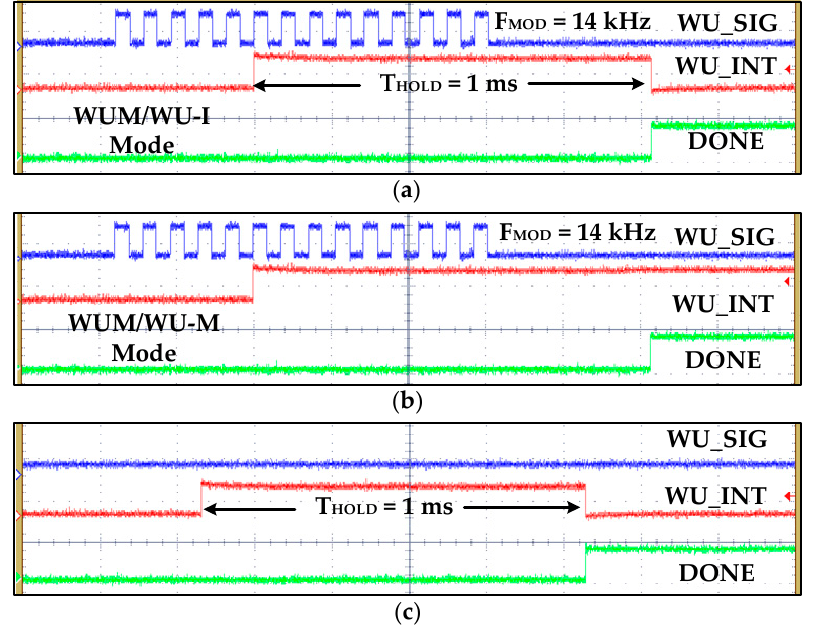
( b ) Figure 15. WuRx measurement result: ( a ) initially, invalid random sequence and then valid wake-up